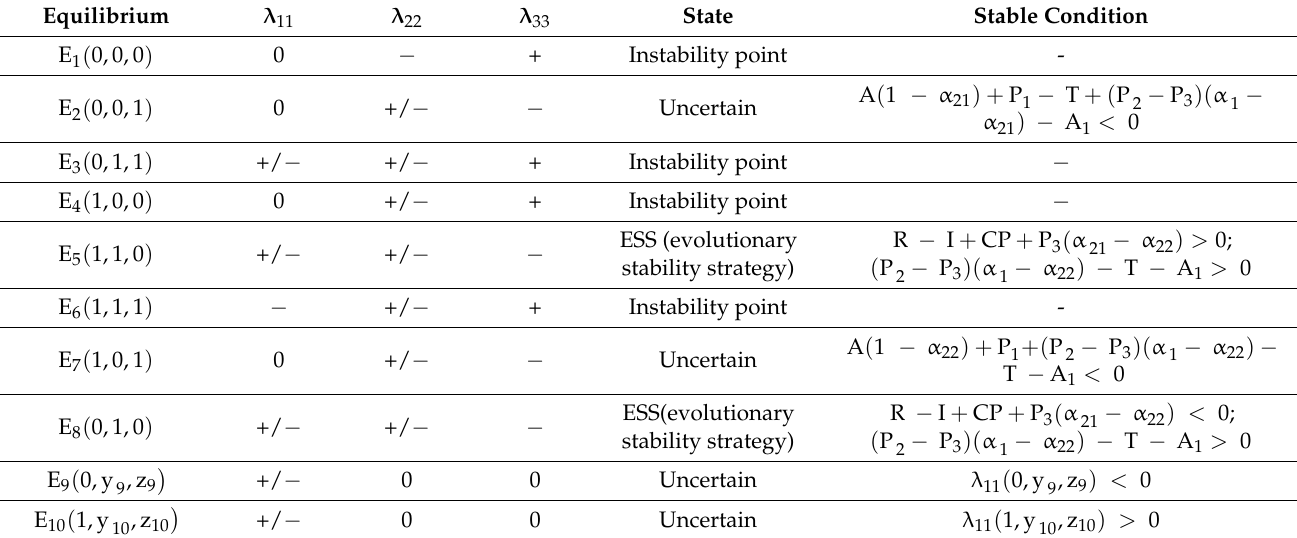
Table 6. Local stability of equilibrium